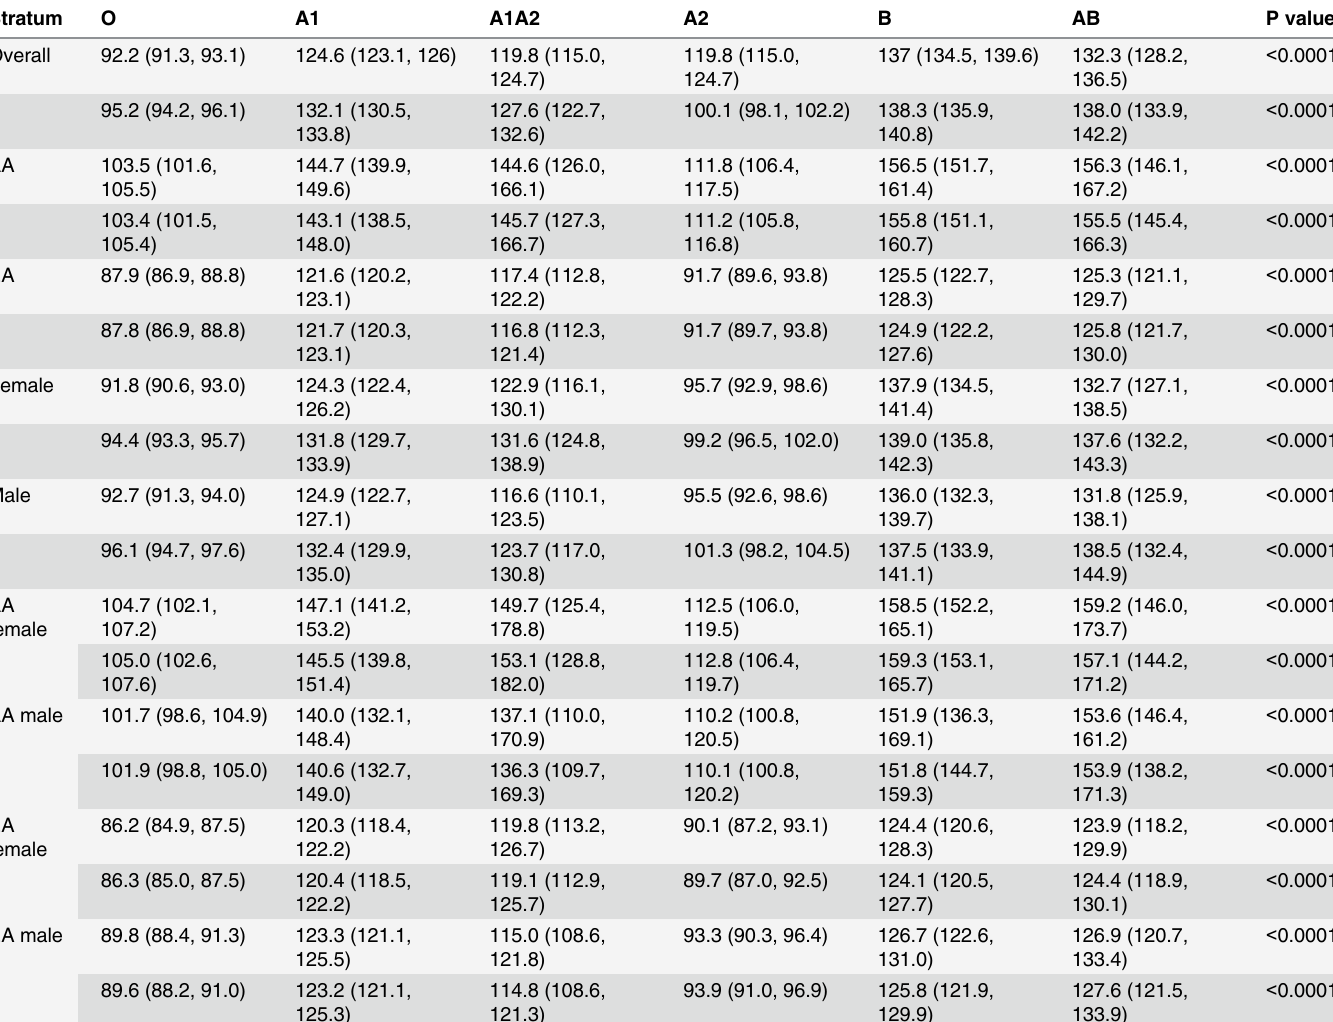
* For all strata, top rows: unadjusted values and bottom rows: values adjusted for age, smoking, BMI, diabetes, and hypertension (race and gender were also included for overall population; race in the gender-speci fi c analyses and gender in the race-speci fi c analyses)